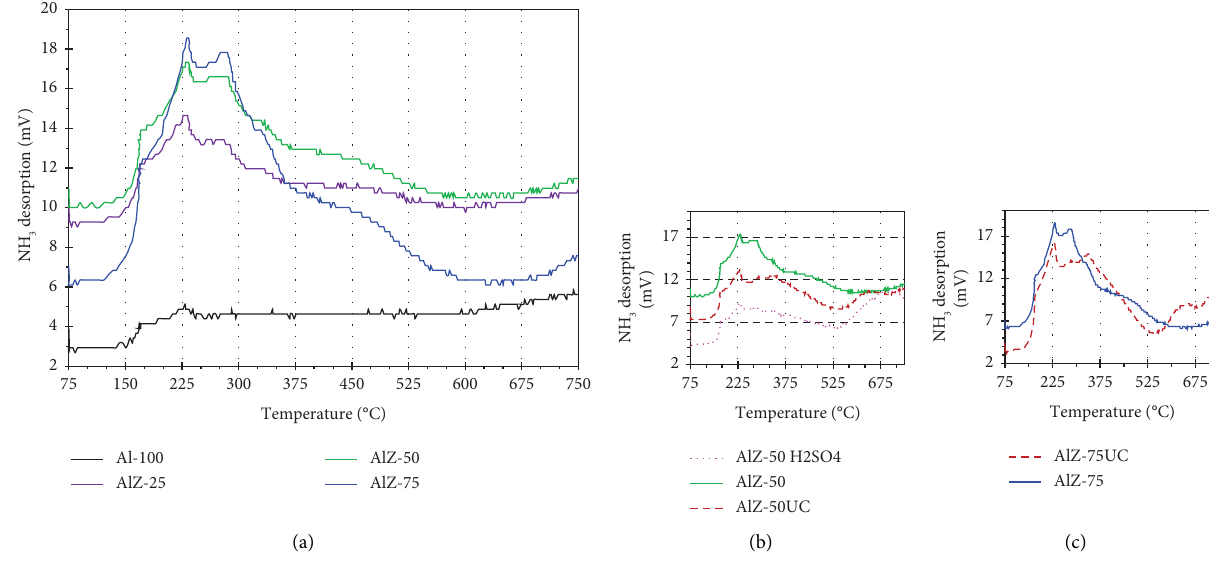
Figure 7: TPD spectra of the various amounts of zeolites (25, 50, and 75 wt% Y) containing